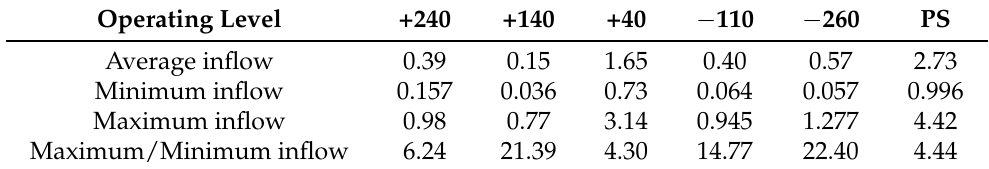
Table 2. Inflow (m 3 /min) to the Nowa Ruda mine workings for the period 1968–1990 [34]. PS—inflow to the pump